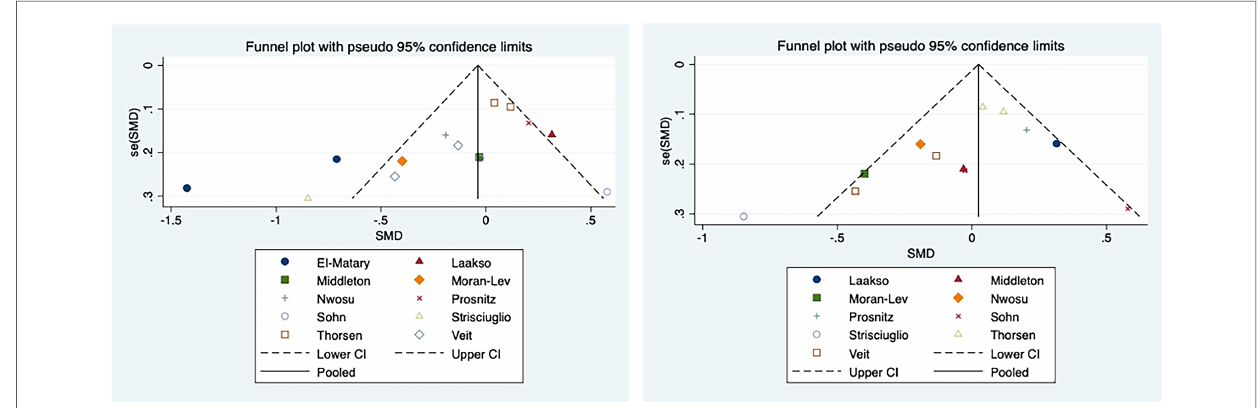
FIGURE 1 Funnel plot including (left) and excluding (right) El Matary 2011. In meta-analysis, publication bias assessment mainly depends on the Egger test. It is generally believed that there is publication bias if p <0.05. In the funnel chart, it was found that one study, El Matary 2011, was far outside the funnel chart and affected the fi nal Egger ’ s test results ( Figure 1 left), and the Egger ’ s test results we used, P =0.037, indicated that there was signi fi cant publication bias. After removing El Matary 2011 ’ s study, the new Egger ’ s test was conducted on the basis of the remaining 12 studies, P =0.164, indicating no signi fi cant publication bias ( Figure 1